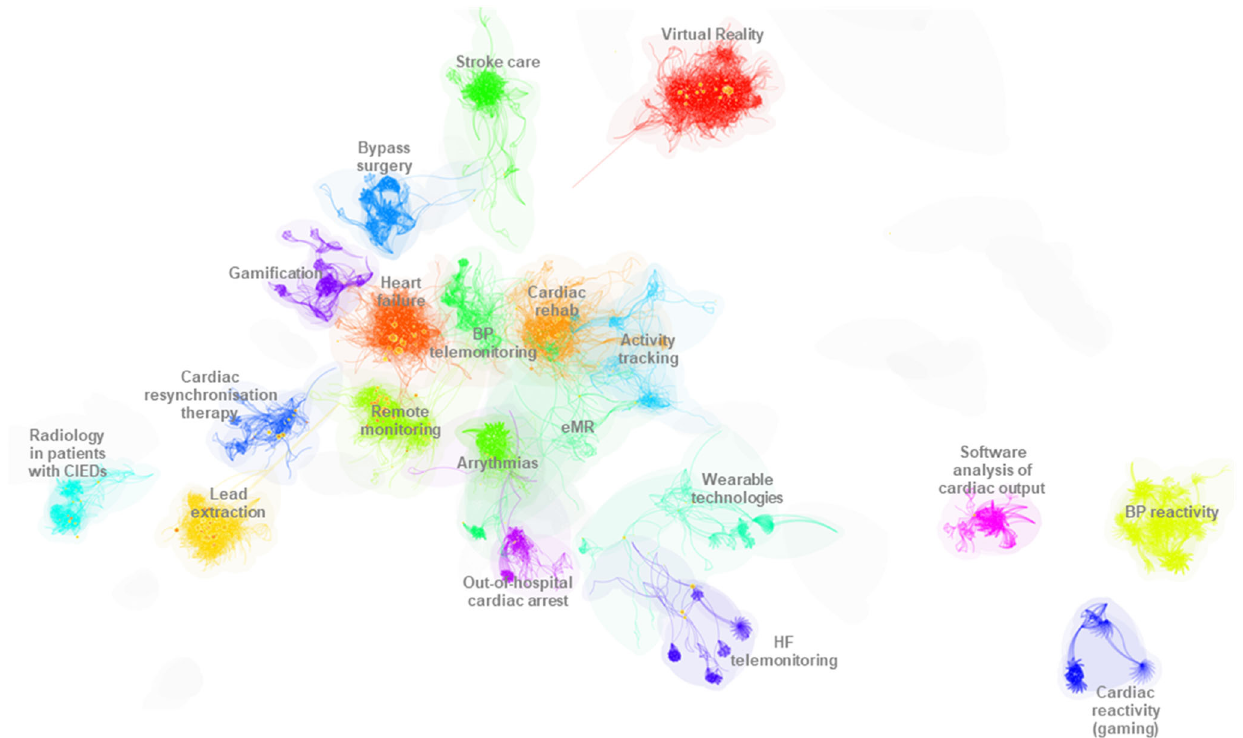
Fig. 5 Birds-eye view of the research areas that digital technologies have been applied in cardiovascular medicine. A dynamic visualisation of the interplay between the research areas (from 1990 to 2021) is accessible via this link Temporal map_digital